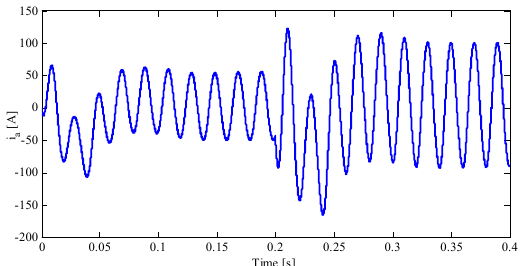
Figure 18. MMC current of phase “a” with MMC input current variations.